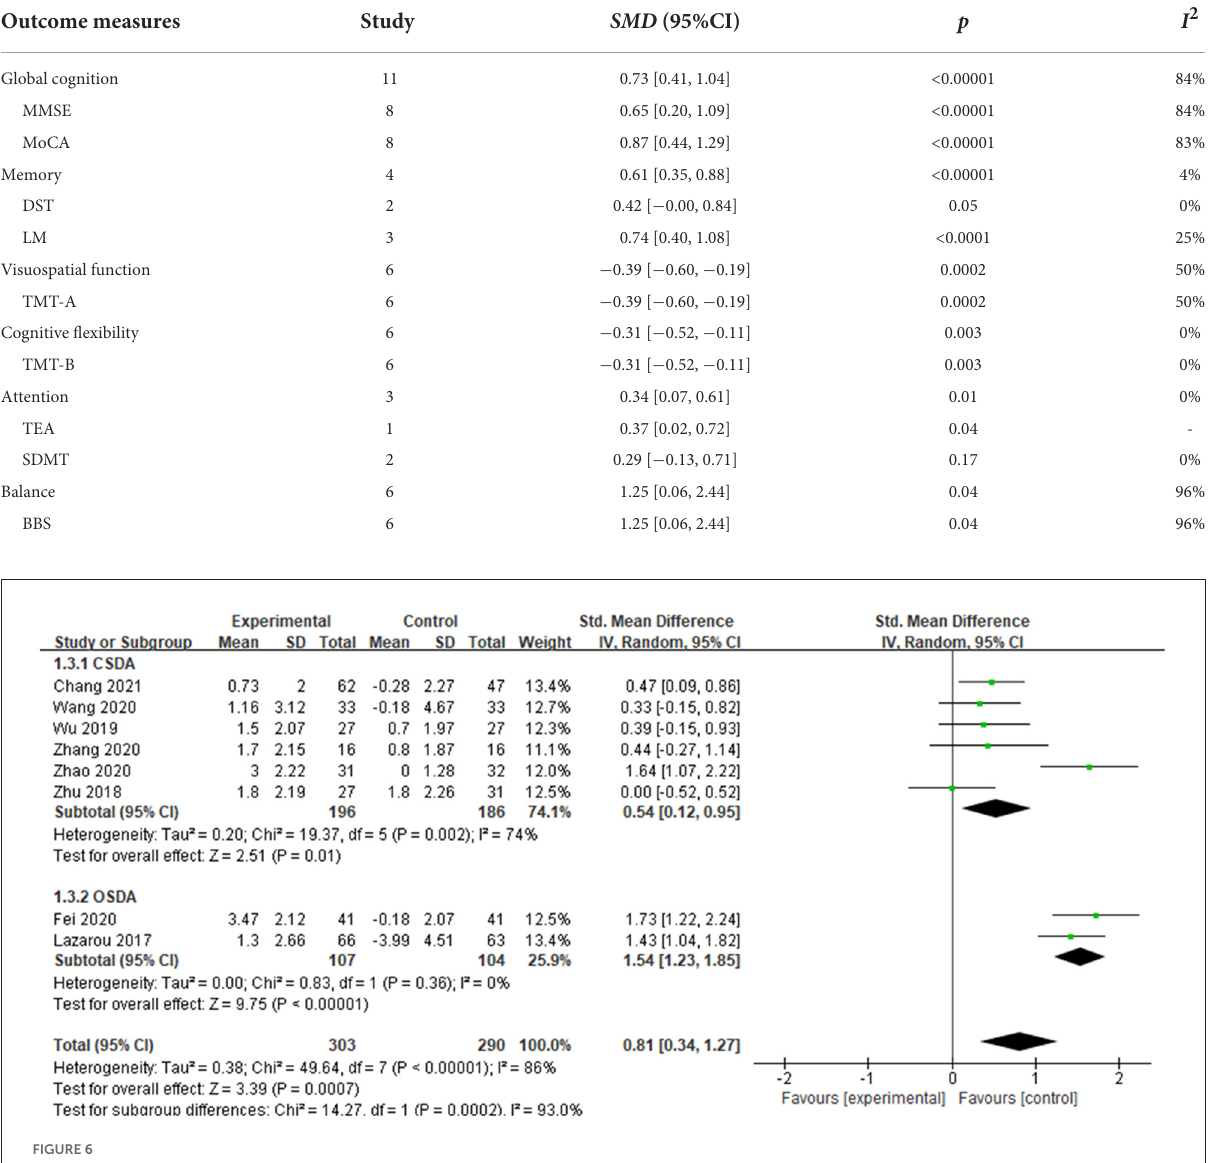
TABLE 3 Summary of the effects of dance activities on cognitive sub-domains.